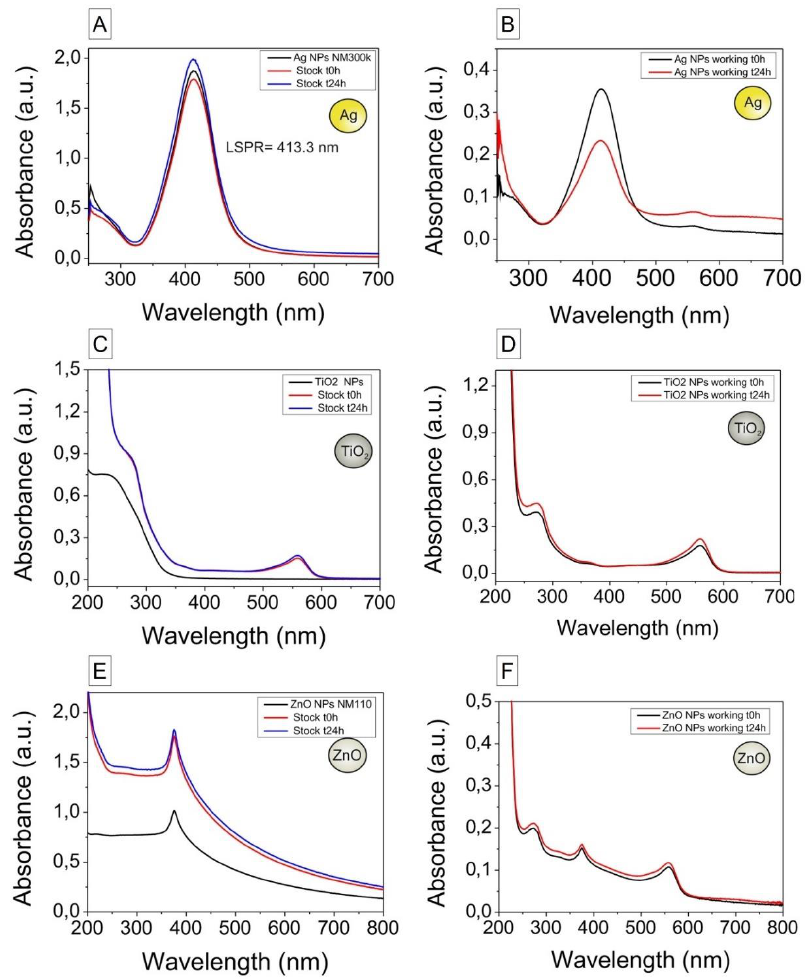
Figure 2. UV − vis spectra of the nanoparticle dispersions diluted in pure water (t = 0 h), as stock dispersions (t = 0 and 24 h) and as working dispersions (t = 0 and 24 h). Samples were diluted 1:200 (Ag), 1:10 (TiO 2 ) and 1:20 (ZnO) in pure water for analysis. ( A ) Ag-NPs in pure water and stock dispersion (2.56 mg / mL). ( B ) Ag-NPs working dispersion (212 µ g / mL, t = 0 and 24 h). ( C ) TiO 2 -NPs in water and stock dispersion (455 µ g / mL, t = 0 and 24 h). ( D ) TiO 2 -NPs working dispersion (212 µ g / mL, t = 0 and 24 h). ( E ) ZnO-NPs in pure water and stock dispersion (2.56 mg / mL, t = 0 and 24 h). ( F ) ZnO-NPs working dispersion (212 µ g / mL, t = 0 and 24 h). The peak at 560 nm can be ascribed to the presence of phenol red in the culture